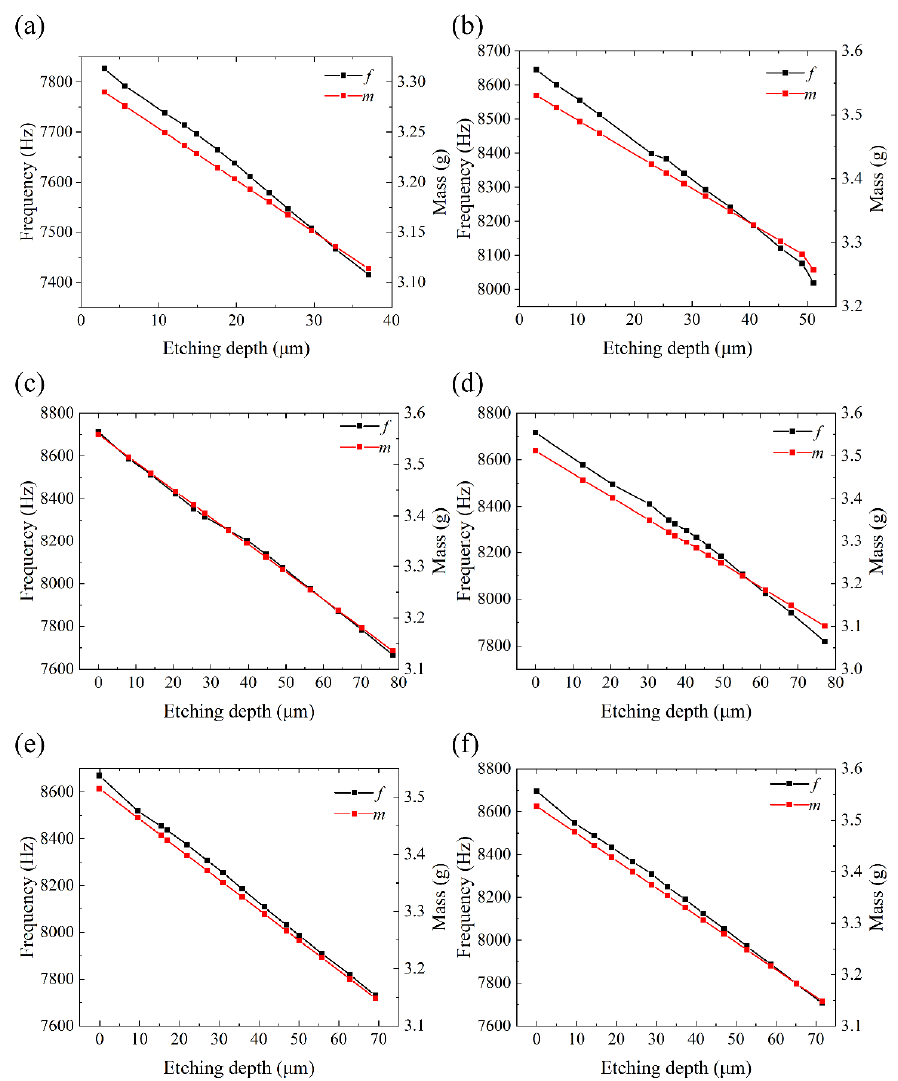
Figure 3. The variation of the resonant frequencies and mass of six resonators with chemical etching depth. ( a ) The variation of resonant frequencies and mass of GR01 with etching depth. ( b ) The variation of resonant frequencies and mass of GR02 with etching depth. ( c ) The variation of resonant frequencies and mass of GR03 with etching depth. ( d ) The variation of resonant frequencies and mass of GR04 with etching depth. ( e ) The variation of resonant frequencies and mass of GR05 with etching depth. ( f ) The variation of resonant frequencies and mass of GR06 with etching depth. The Q factors of the six resonators are measured inside the vacuum chamber (0.02